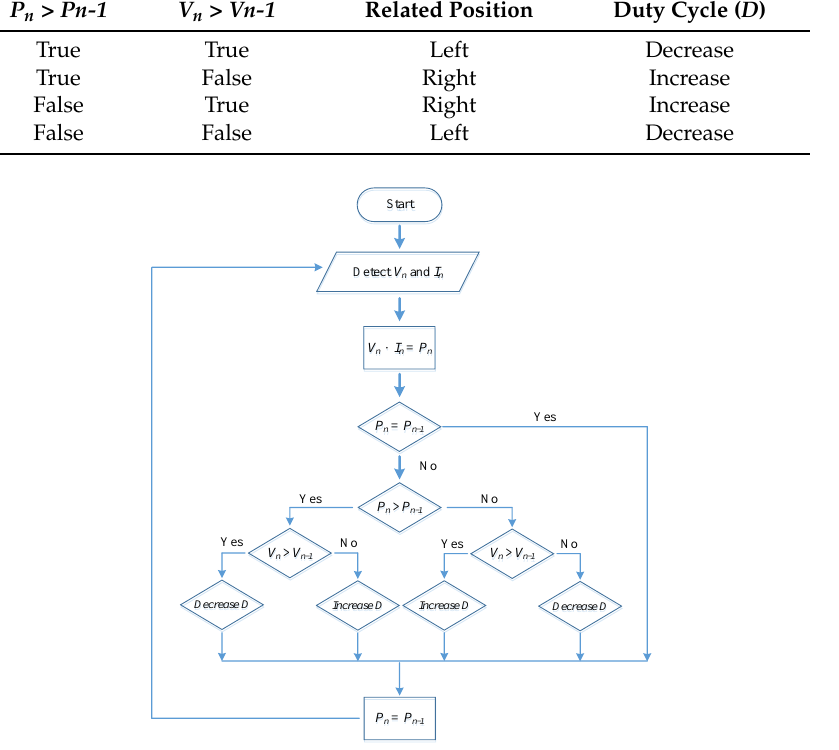
Figure 5. The flowchart of the perturb-and-observe method.